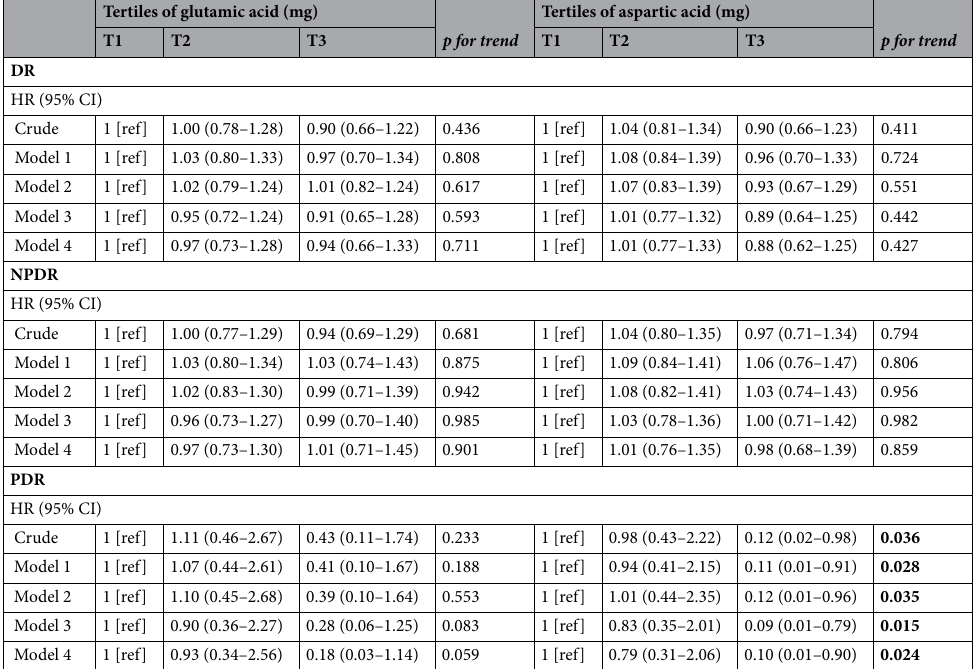
Table 3. Hazard ratios for diabetic retinopathy incidence according to tertiles of glutamic acid and aspartic acid intake (mg). By Cox proportional hazard models. DR, diabetic retinopathy; NPDR, isolated non- proliferative diabetic retinopathy; PDR, proliferative diabetic retinopathy. Model 1: adjusted for age and sex, Model 2: adjusted for Model 1 + HbA1C, duration of diabetes, Model 3: adjusted for Model 2 + education, income, occupation, Model 4: adjusted for Model 3 + CrCl, ALT,